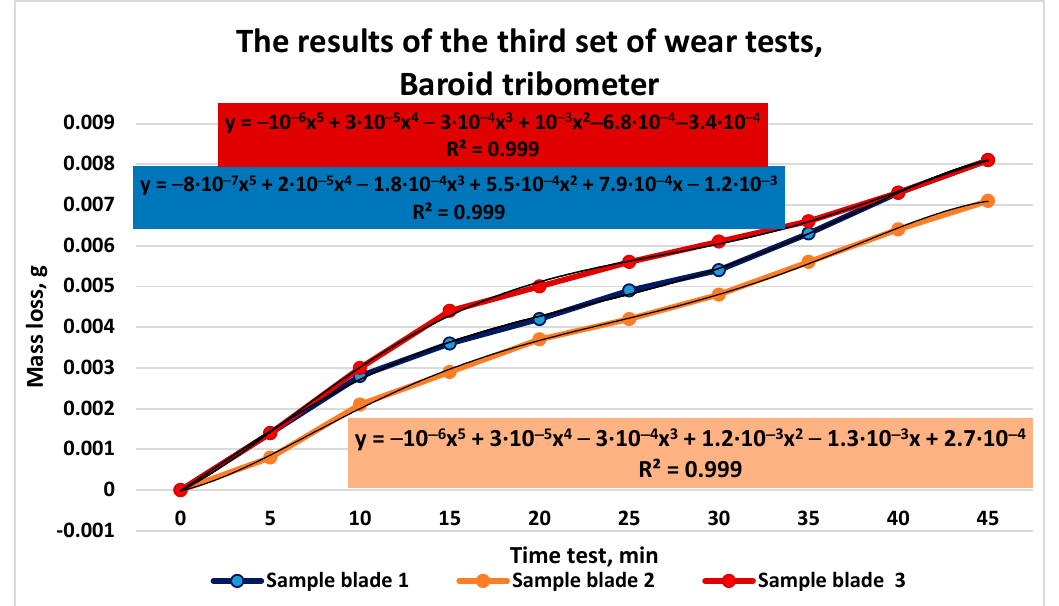
Figure 13. The results of the third set of wear tests.